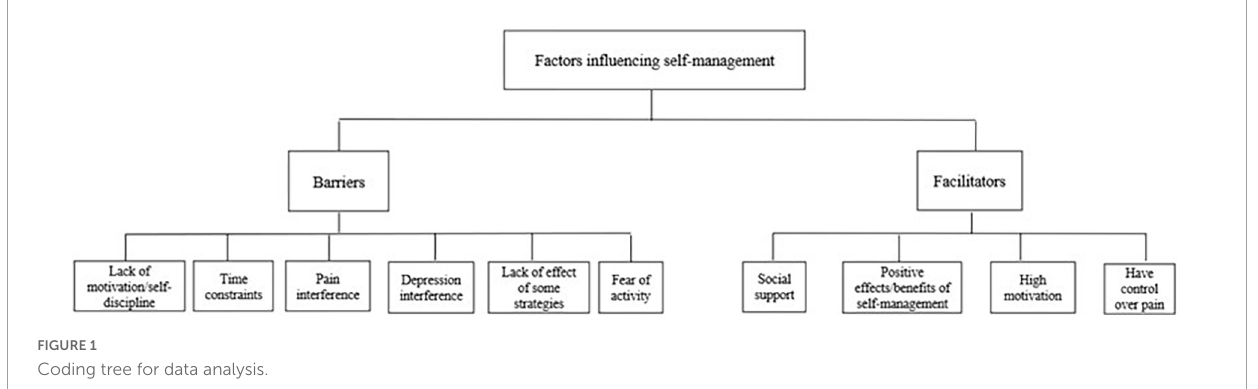
FIGURE1 Coding tree for data